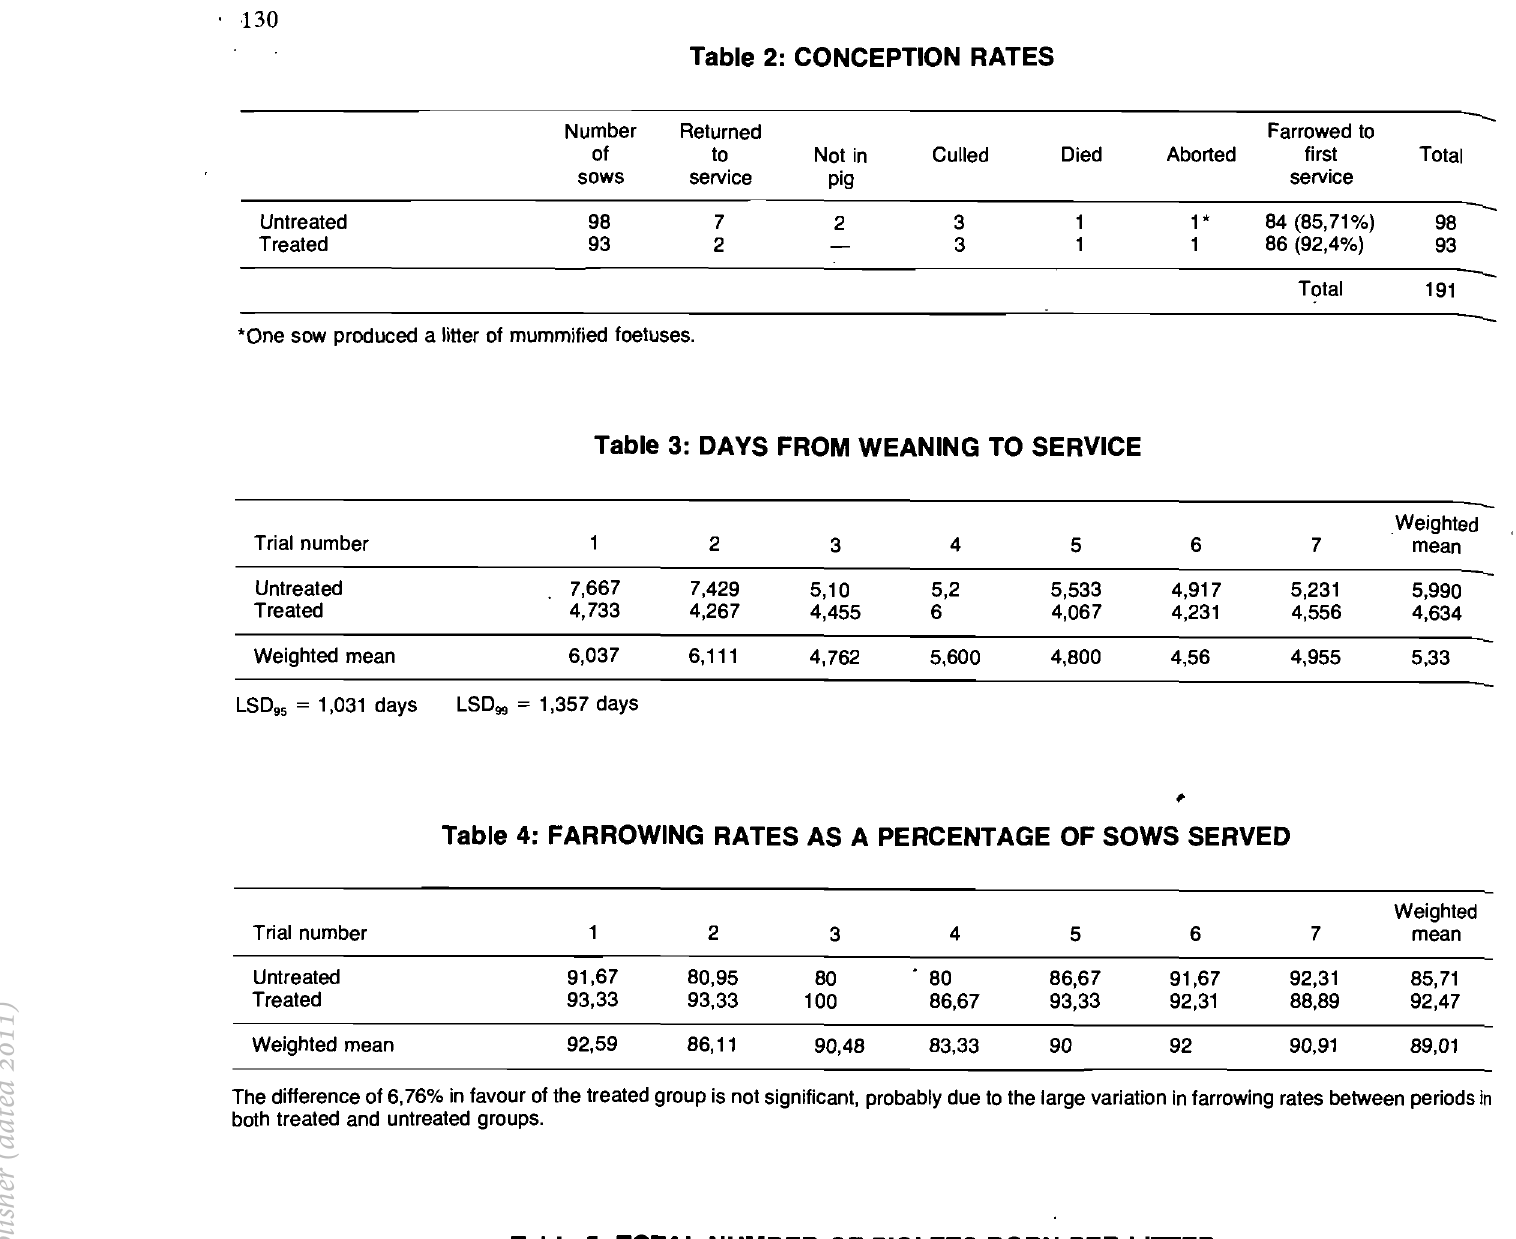
Table 5: TOTAL NUMBER OF PIGLETS BORN PER LITTER